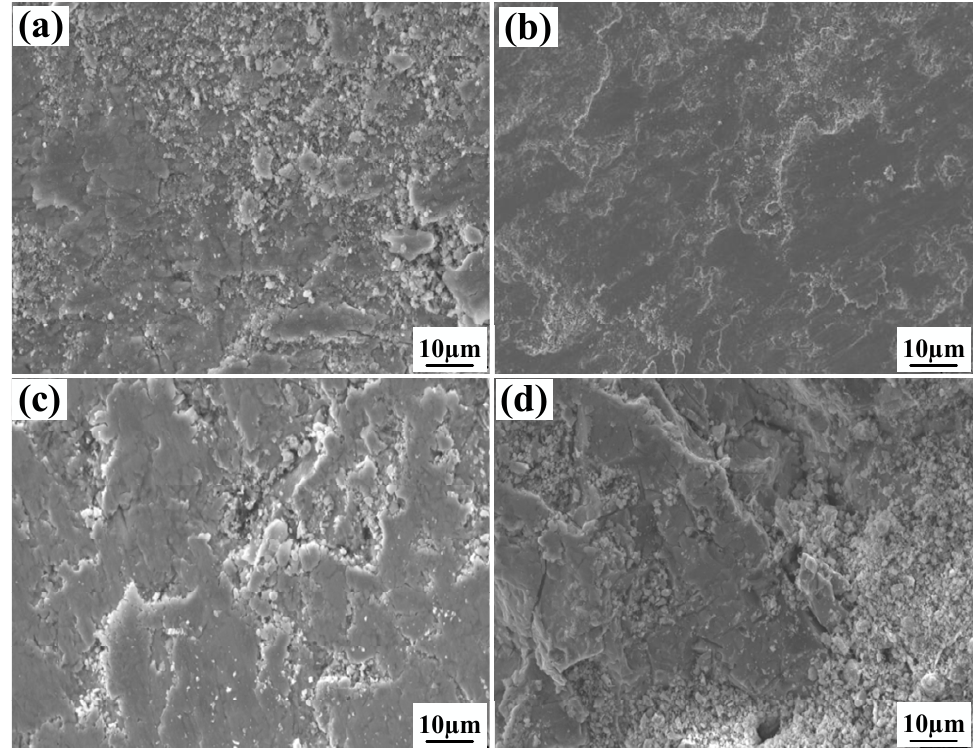
Figure 13. The influence of graphene content on the wear morphology of the coating: ( a ) 0% graphene content; ( b ) 0.5% graphene content; ( c ) 1.0% graphene content; ( d ) 1.5% graphene content.